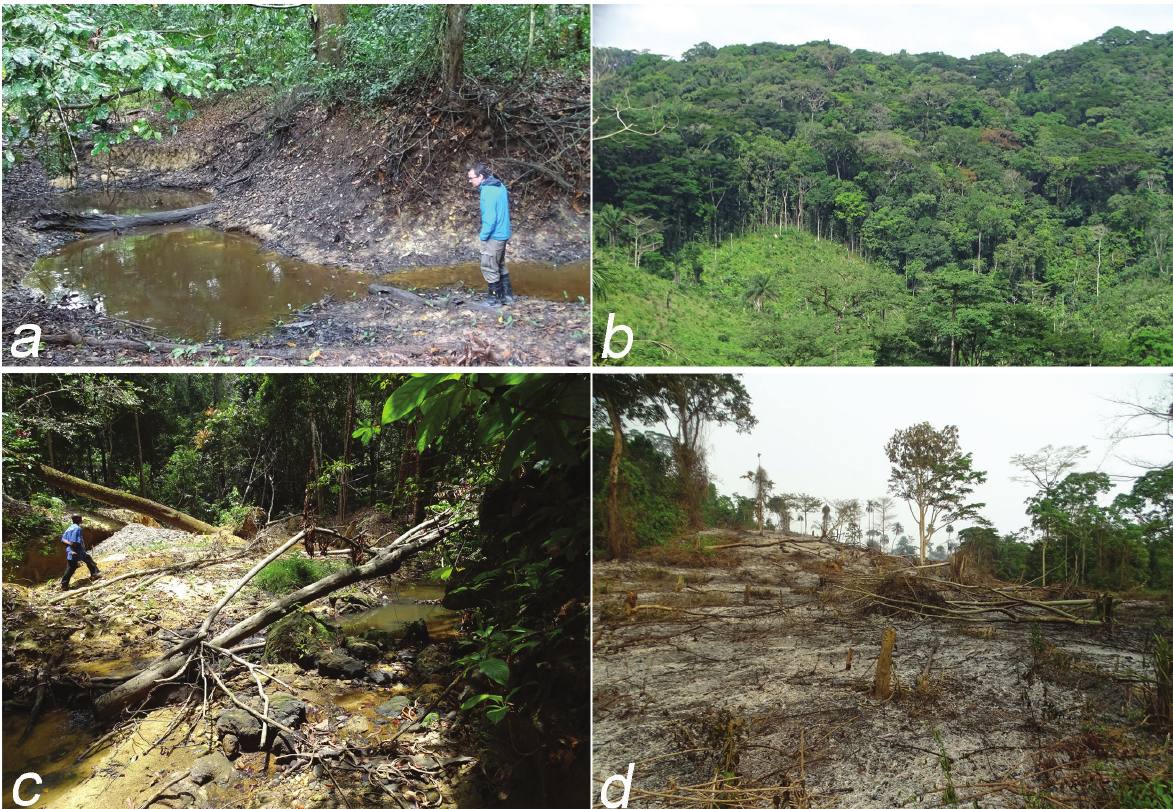
Figure 1. Natural and disturbed habitats in the Krahn-Bassa (KBPPA) and Foya Proposed Protected Areas (FPPA). a Remaining puddles of a stream in Krahn-Bassa, habitat of Aubria subsigillata , Amnirana ‘albolabris West’, Leptopelis macrotis , Hyperolius chlorosteus and Chiromantis rufescens . b View on a near primary forest patch in FPPA. c Artisanal gold mining area near a small forest stream in FPPA, frogs breeding in these puddles were Xenopus tropicalis, Sclerophrys maculata, Hyperolius picturatus, Phlyctimantis boulengeri, Ptychadena longirostris , P. sp., and Chiromantis rufescens . d Recently slash and burn cleared forest patch in FPPA, prepared for establishing a cacao